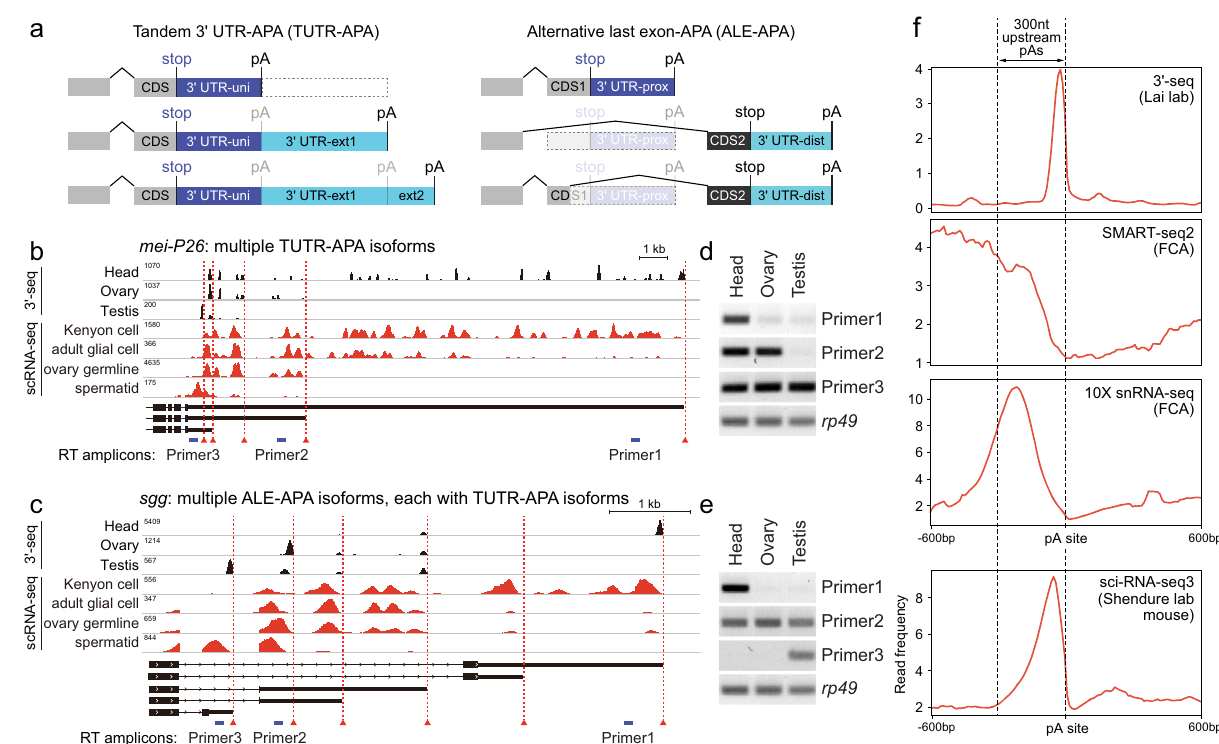
Fig. 1 | 10X sNuc-seq data reveals cell-speci fi c programs of 3 ’ isoforms. a Two classes of 3 ’ mRNA isoforms generated by alternative polyadenylation (APA). Left, tandem3 ’ UTR(TUTR)isoformsencode the sameopenreadingframe, but express different 3 ’ UTRs. Here, a gene model incorporates three different TUTR isoforms. Right, alternative last exon (ALE) isoforms harbor different C-terminal coding potential, in addition to non-overlapping 3 ’ UTR contents. While ALE isoforms could be generated as a result of splicing regulation, in at least some cases, ALE isoforms are determined via APA. Here, two examples of exon layouts that can generate distal ALE switching are shown. b Exemplar gene ( mei-P26 ) with highly alternative TUTR isoforms evidence in bulk 3 ’ -sequencing from the indicated tis- sues (black tracks), for which corresponding varieties of TUTR isoforms can be found in individual cell types originating from the same tissues (red tracks). c Exemplargene ( sgg ) with diverse ALE isoforms (three distinctcoding potentials),